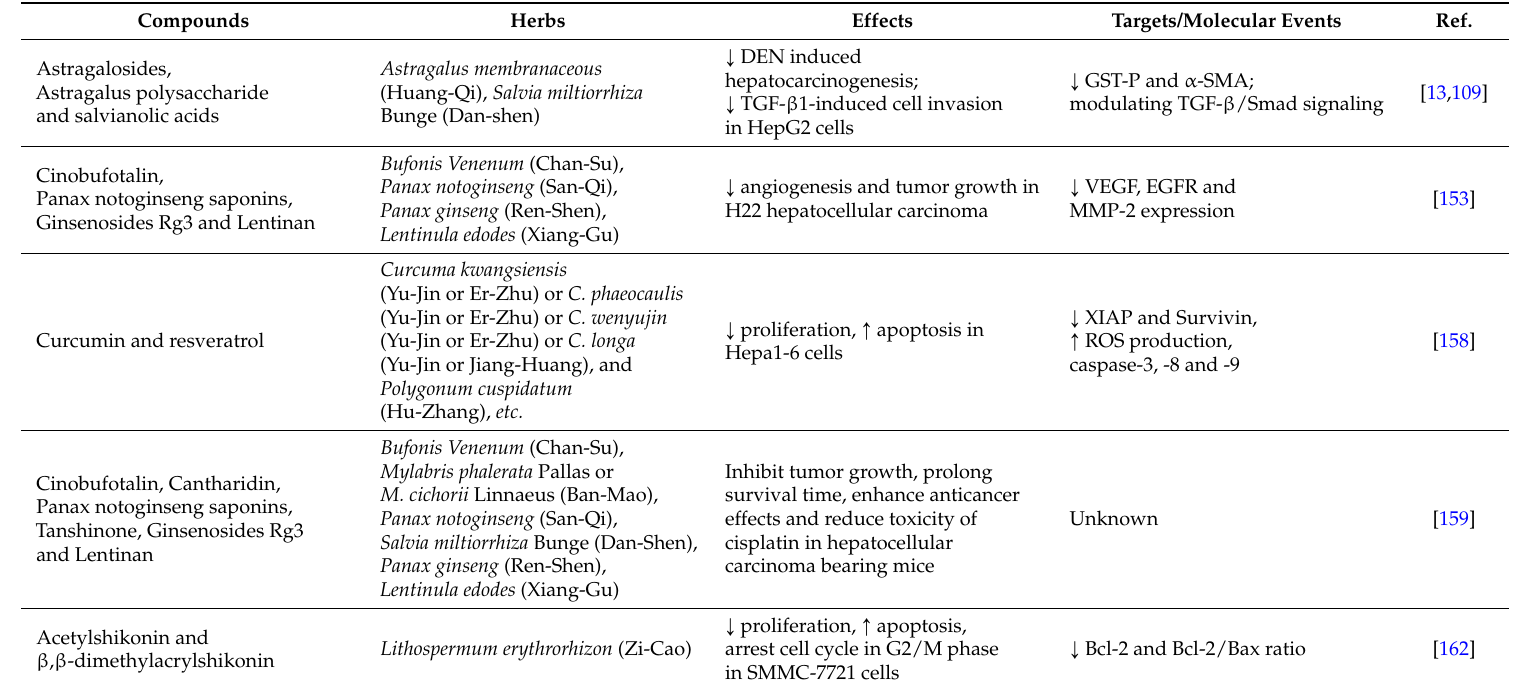
Table 4. Herbal compound-based combinational